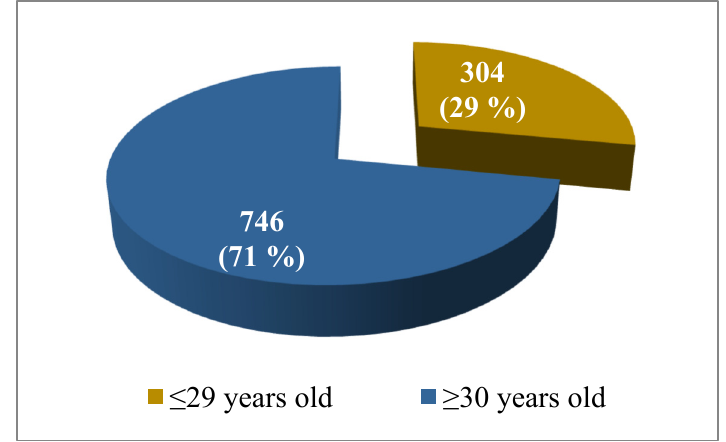
Figure 1. Age distribution in the total number of tested women ( N = 1050).